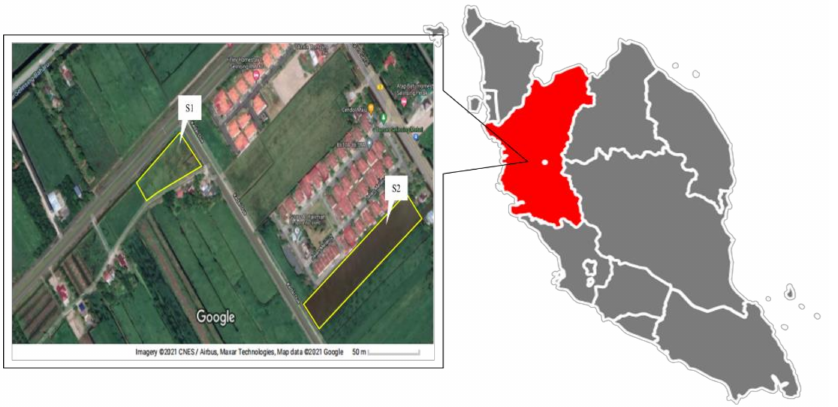
Figure 2. Site Sampling at Bagan Serai, Perak,